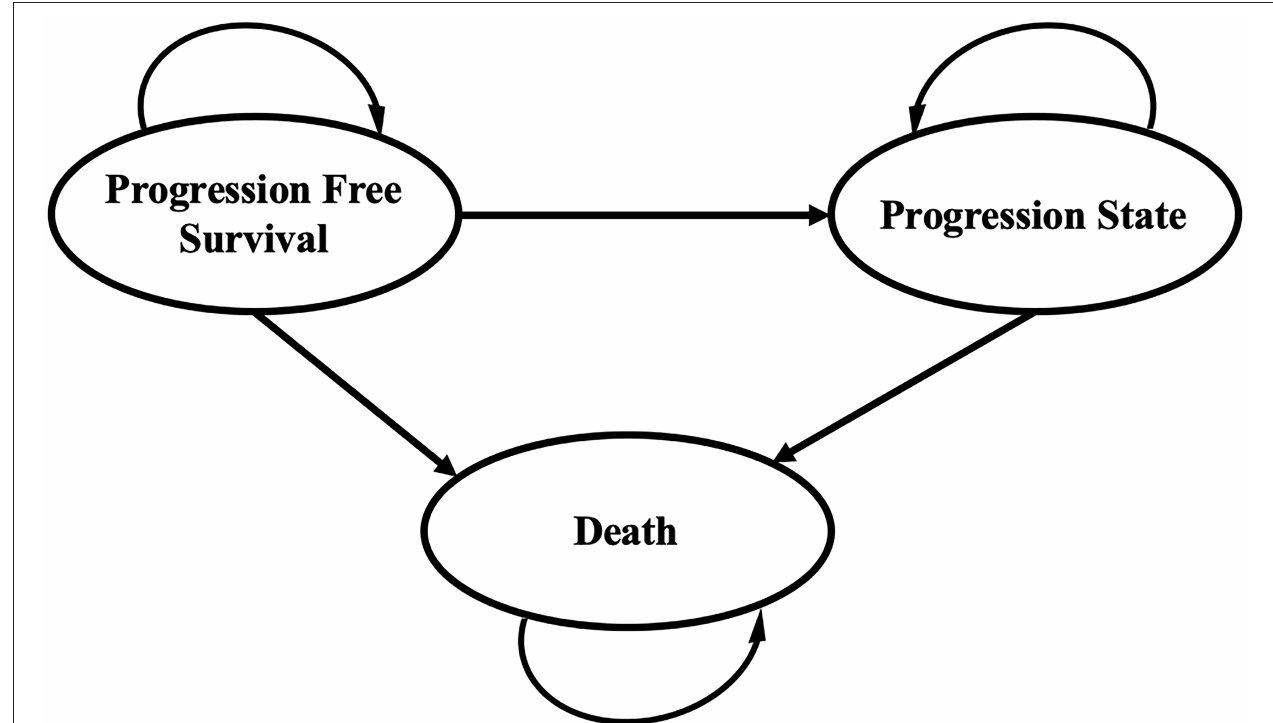
FIGURE 1 | Markov model for advanced endometrial cancer. A Markov model comprising three health states was